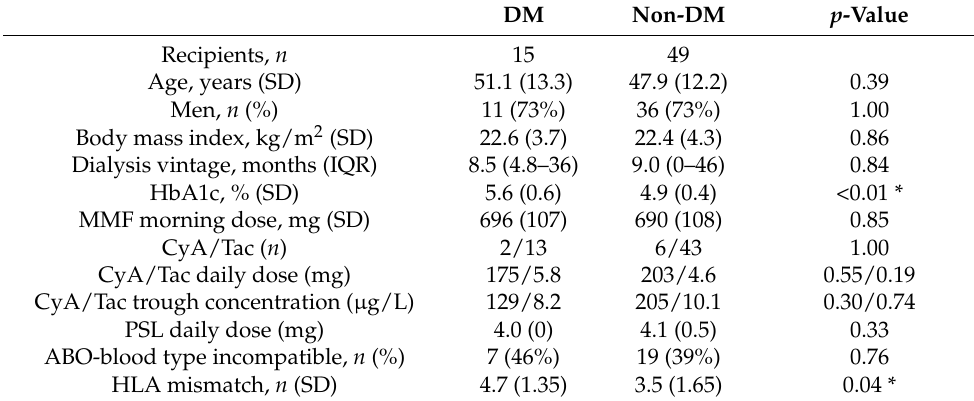
Table 1. Baseline recipient characteristics stratified by the diabetes